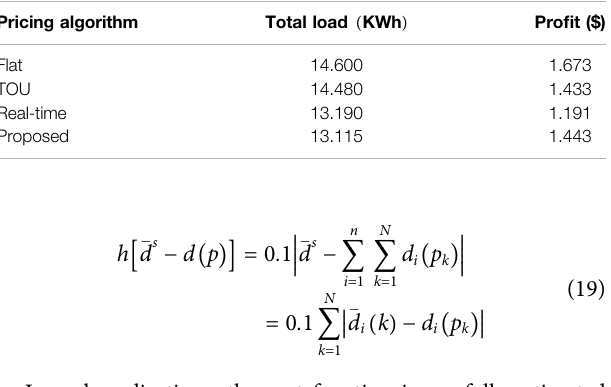
TABLE 3 | Comparison of three pricing